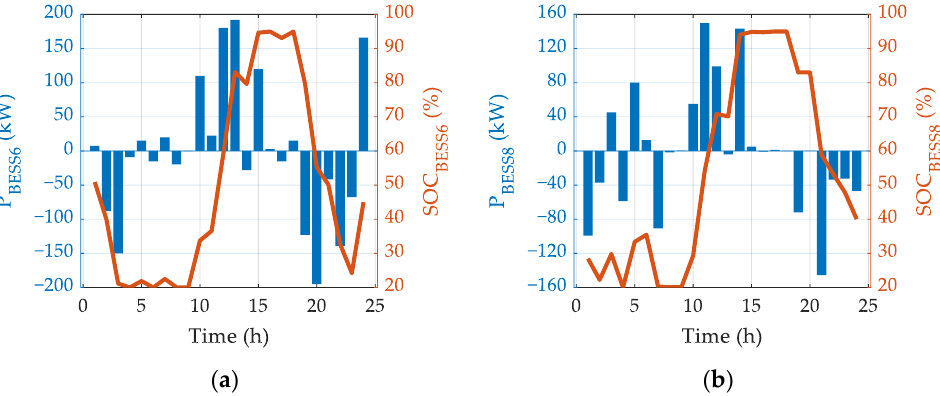
Figure 6. The optimal scheduling for the BESS connected at ( a ) bus 6 and ( b ) bus 8, determined after the first stage of OARPC for the selected day.